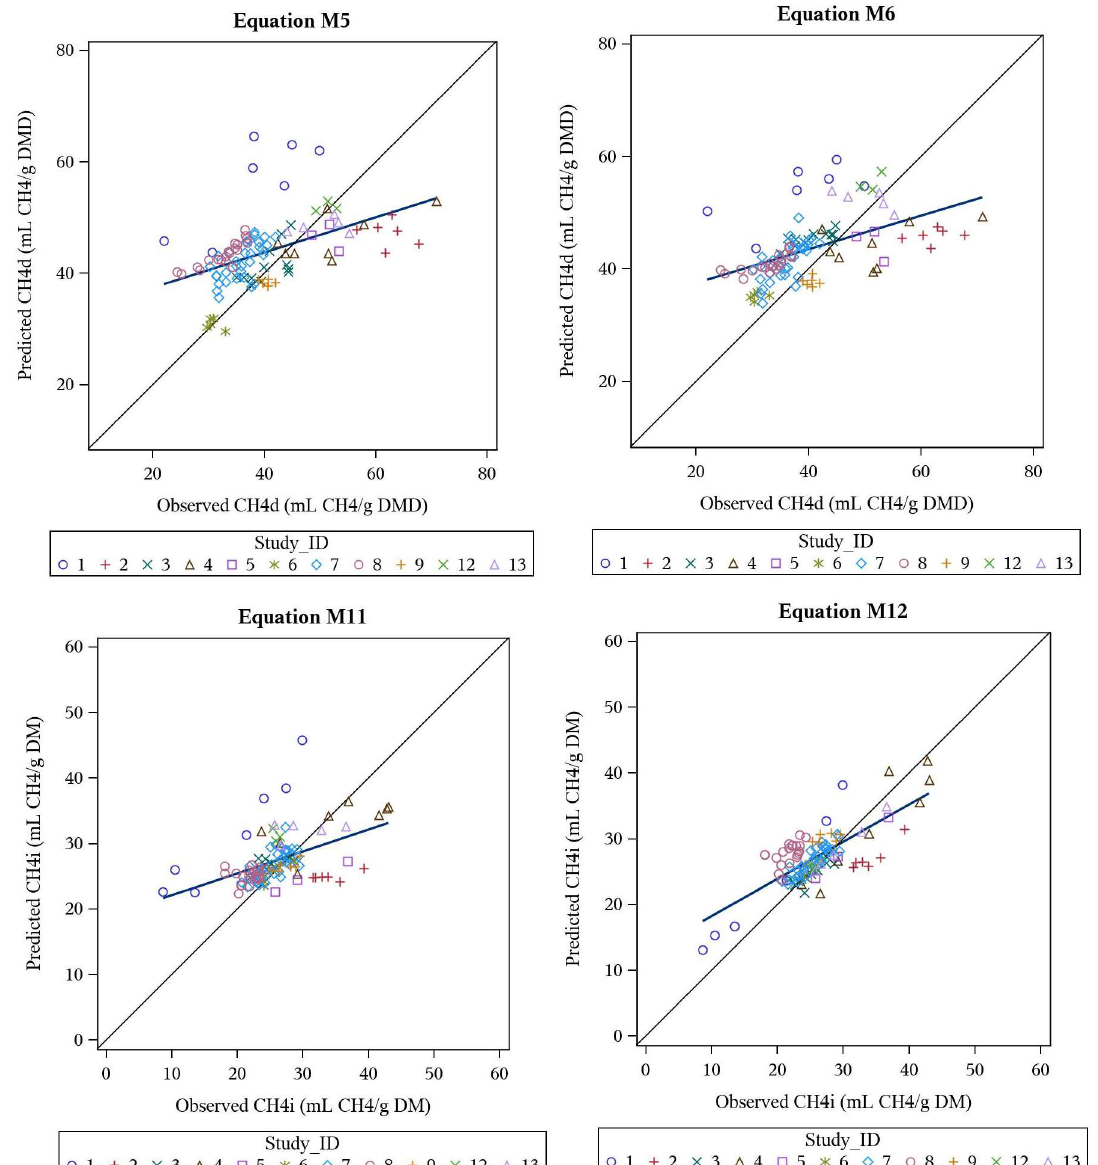
Figure 1. Predicted vs. observed plots for the top four performing meta-analysis equations M5 (CH 4 d), M6 (CH 4 d), M11 (CH 4 i) and M12 (CH 4 i), as evaluated on the evaluation dataset ( n = 107).